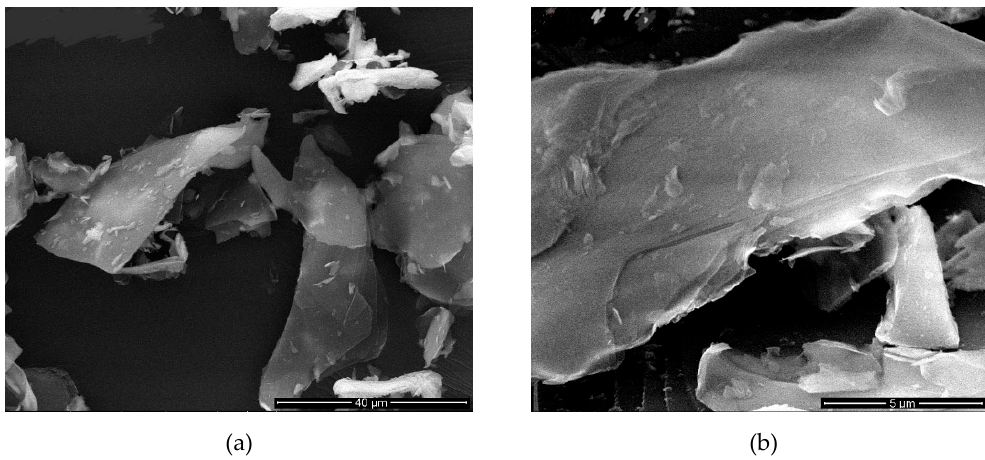
(b) Figure 12. SEM images of the M x2c3 sample with a sonication time of 7 h with higher magnification ( a ) 3000×; ( b ) 20,000×.